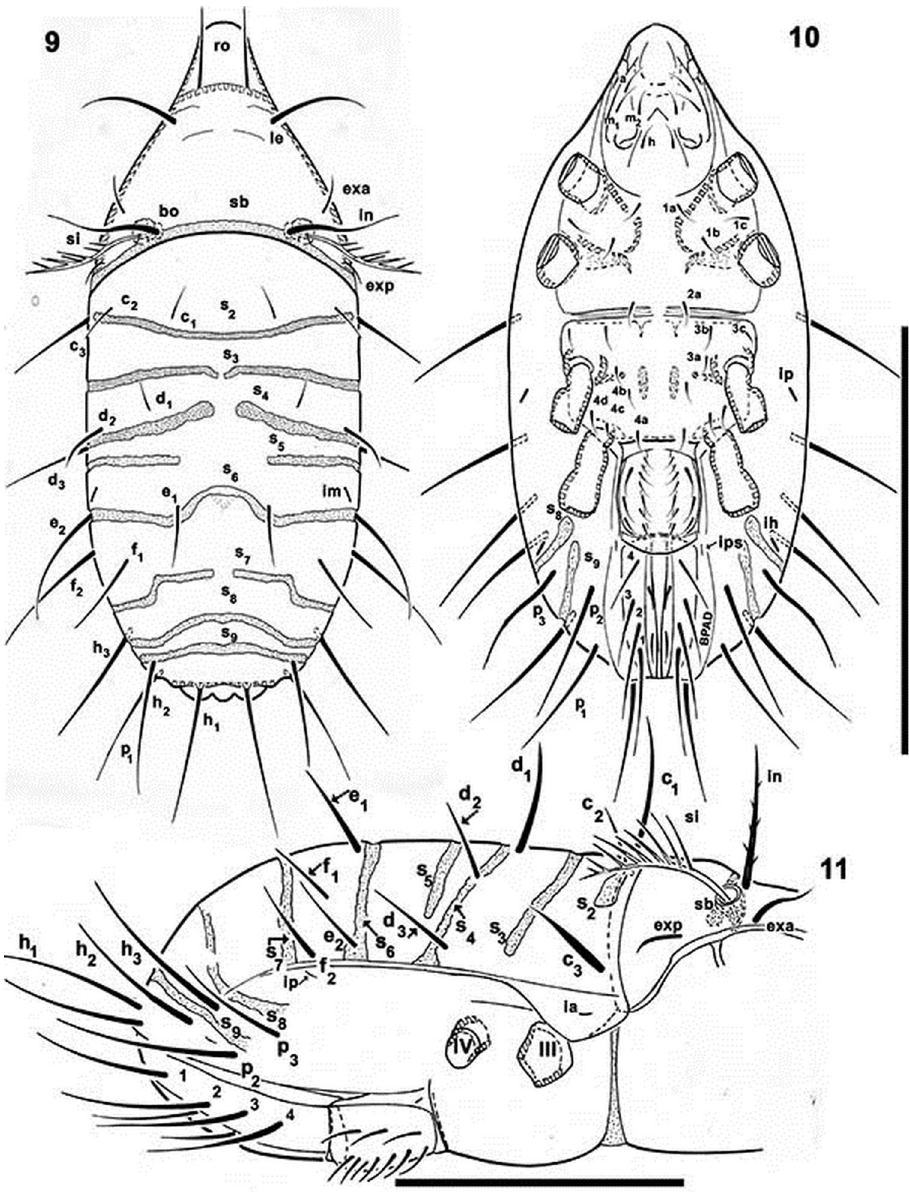
Figures 9–11. Mixacarus turialbaiensis sp. n. Adult, optical microscopy. 9 dorsal view 10 ventral view 11 lateral view . Abbreviations: See Material and methods. Scale bars: 9, 10 = 300 μm; 11 = 200